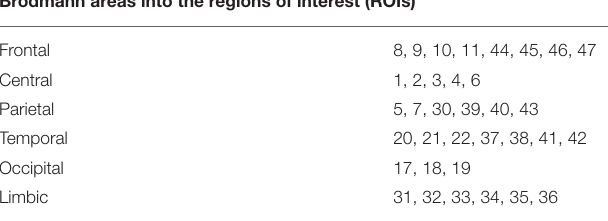
TABLE 2 | Regions of interest (ROIs) for the estimation of the cortical sources of resting state eyes-closed electroencephalographic (EEG) rhythms by exact low-resolution brain electromagnetic tomography (eLORETA) software. Brodmann areas into the regions of interest